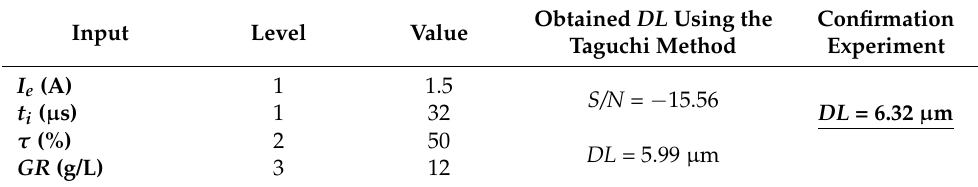
Table 5. Optimal se tt ing of input parameters with con fi rmation experiment. Table 5. Optimal setting of input parameters with confirmation